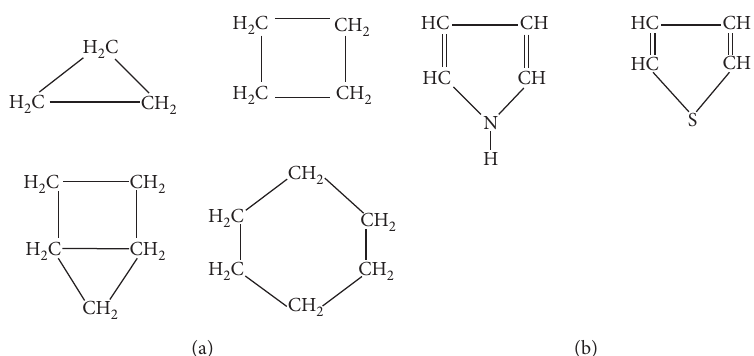
Figure 3: (a) The set of Lewis structure of cyclopropane, cyclobutane, cyclopentane, and cyclohexane, (b) the set of Lewis structure of pyrrole and thiophene.